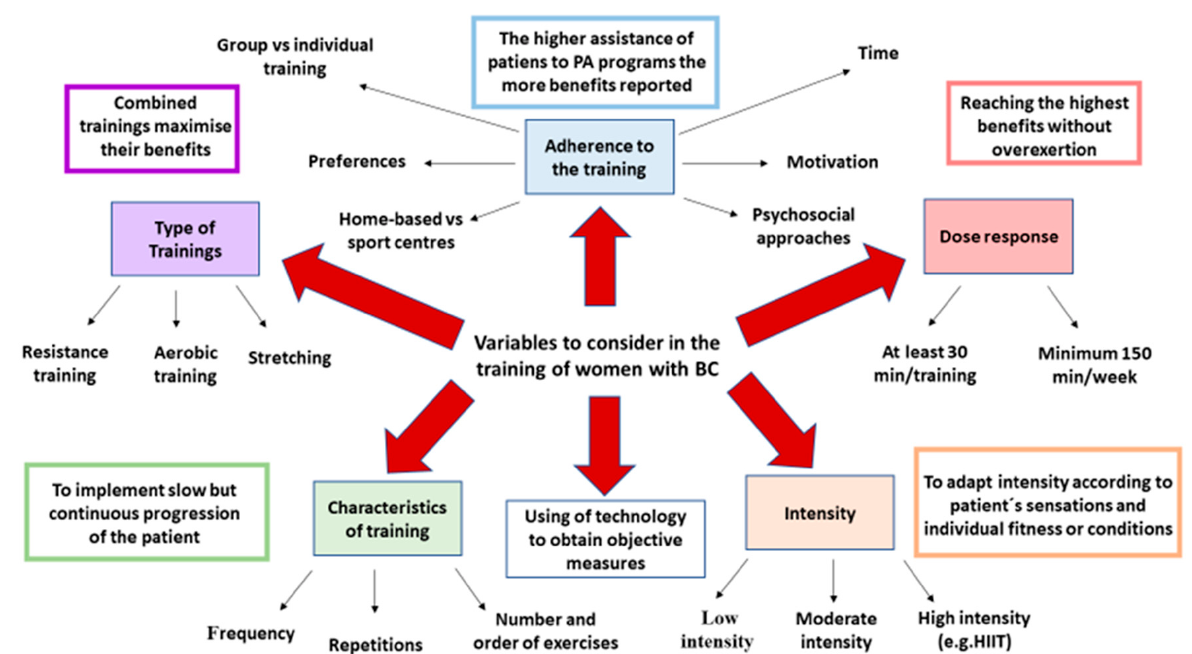
Figure 2. The multiple factors to consider in the training of women with BC. As described above, types of trainings, adherence to the program, dose-response effects, intensity, and variables of the training are crucial to understand and maximize the benefits of PA interventions. Using of technology may also aid in obtaining objective measures that together with subjective measures, motivation, and constancy, determine the basis of a successful training program.